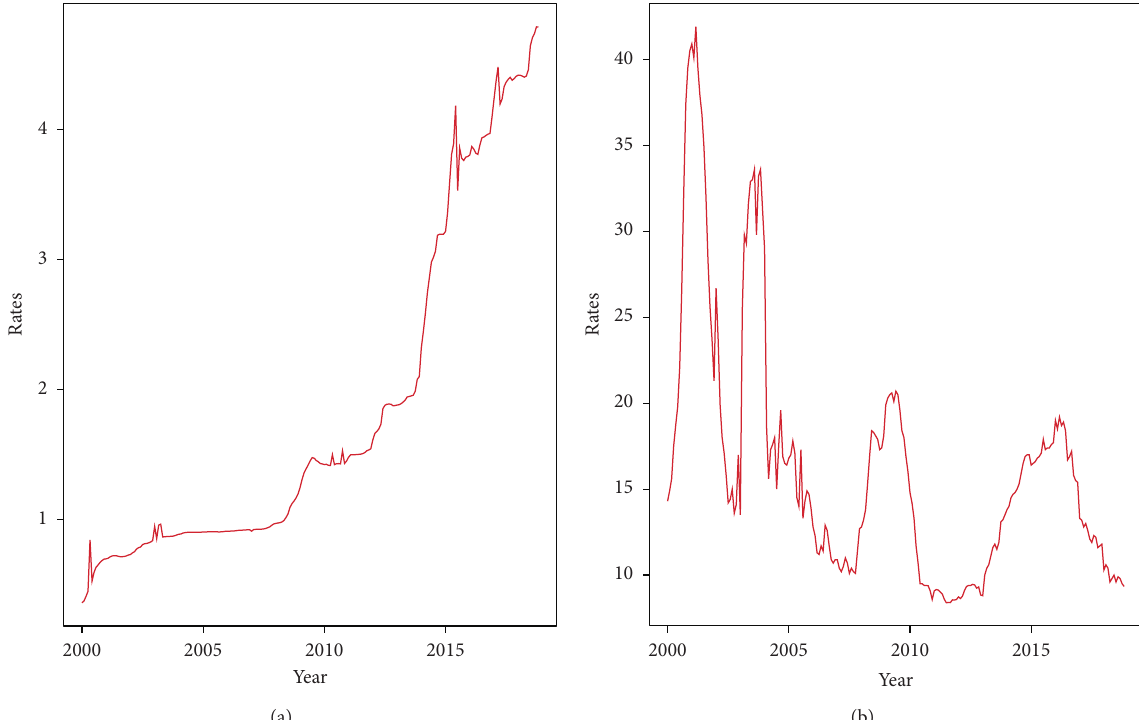
Figure 1: Plot of (a) monthly exchange rates (USD) of Ghana and (b) monthly inflation rates of Ghana.